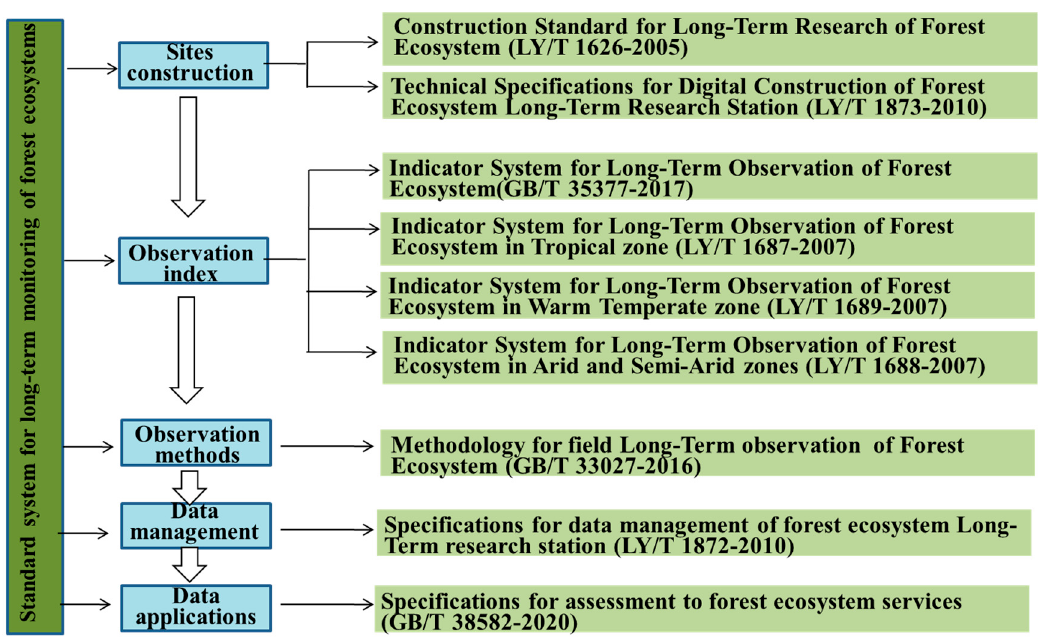
Figure 2. Standard system structure used for Long-Term monitoring of forest ecosystems as part of the CFEIS.